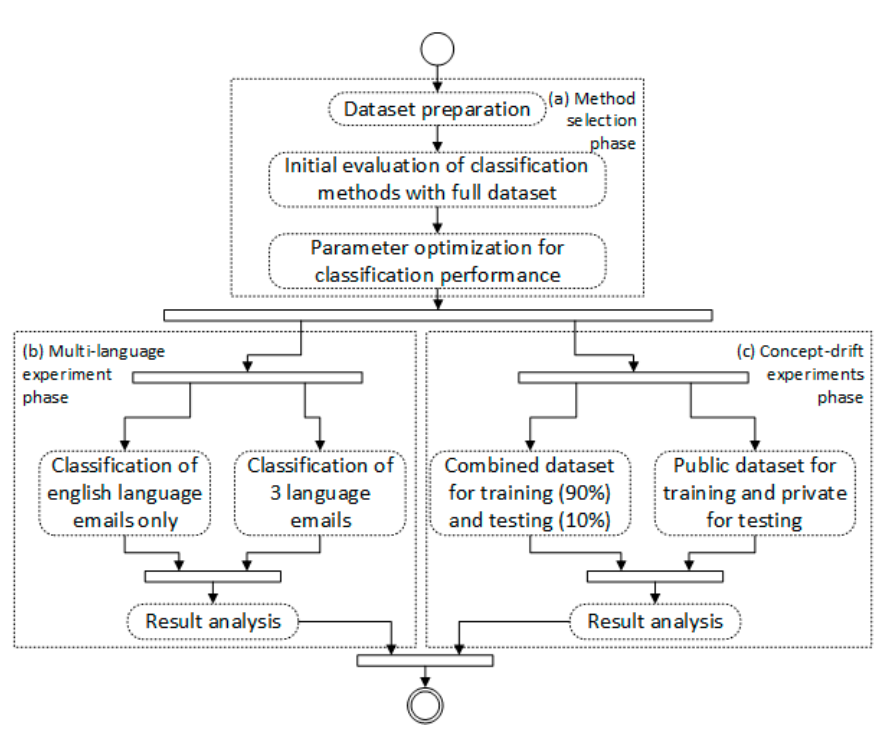
Figure 1. Workflow diagram of the research. ( a ) Method selection phase, ( b ) Multi-language experiment phase, ( c ) Concept-drift experiments phase.